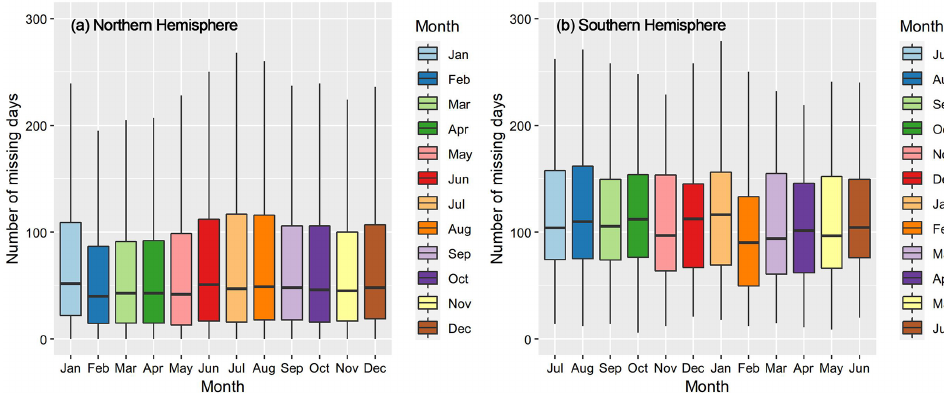
Figure 5. Number of missing days in different months during 1981–2020 for the HadISD-Humidity dataset. The lower and upper hinges correspond to the 25th and 75th percentiles, and the horizontal lines in the boxes show the medians. The lower and upper whiskers are the minimum and maximum values.